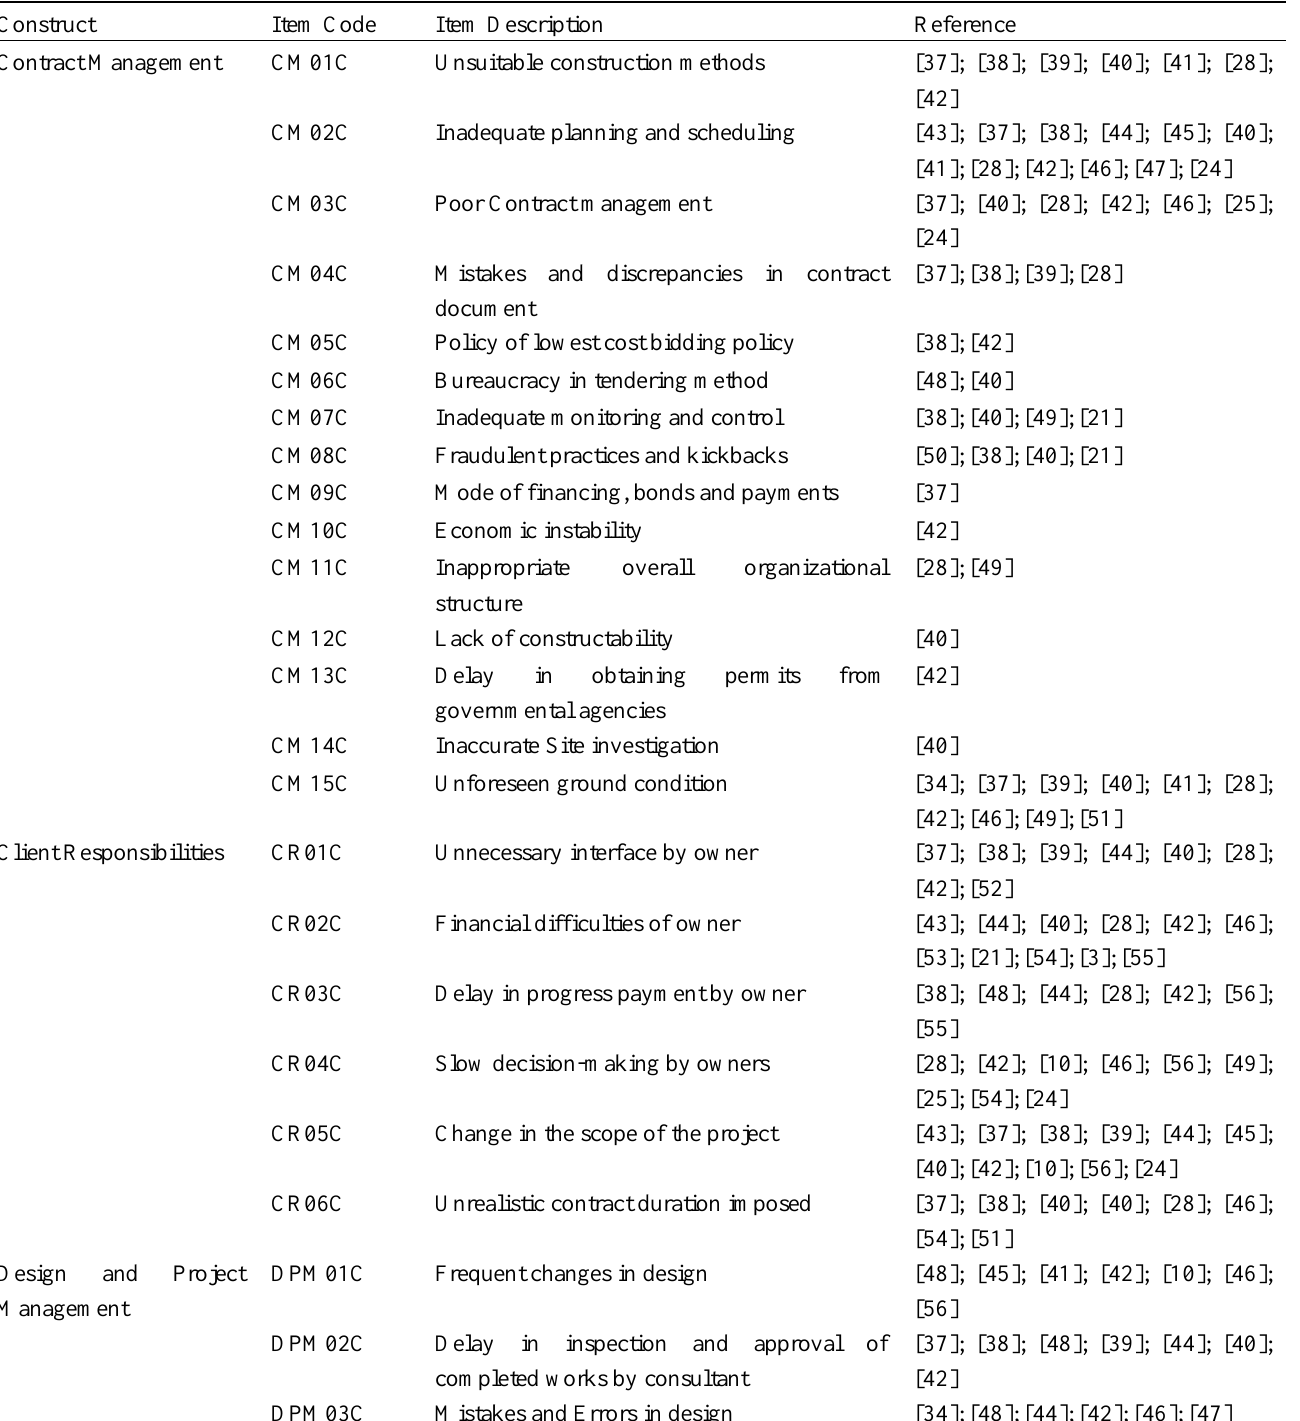
The Factors Causing Cost Overrun in Construction Projects